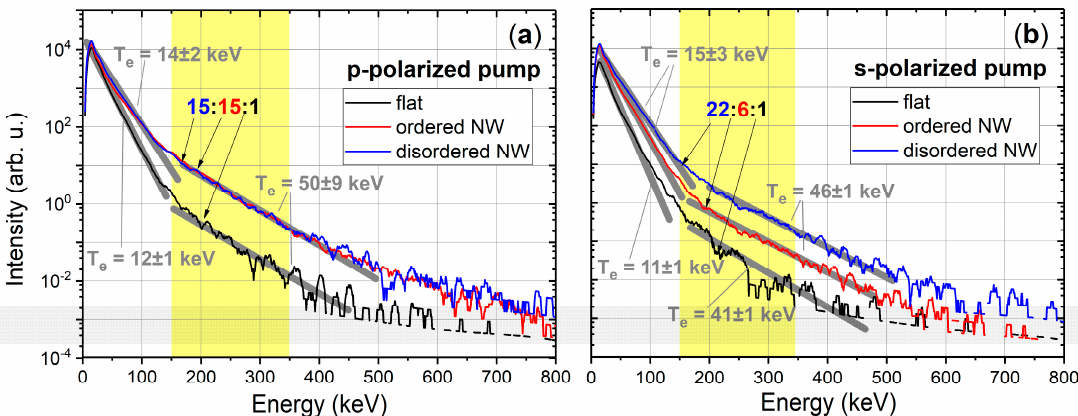
Figure 5. Hard X-ray spectra from the flat (black line), ordered (red line), and disordered (blue line) nanostructured ZnO targets for p-polarization ( a ) and s-polarization ( b ) measured by the Timepix detector. Relation of the hard X-ray flux is given for the marked (yellow) energy range. The spectra were fitted with an exponential function (solid grey line) providing an estimation of the electron “hot” temperatures T e .